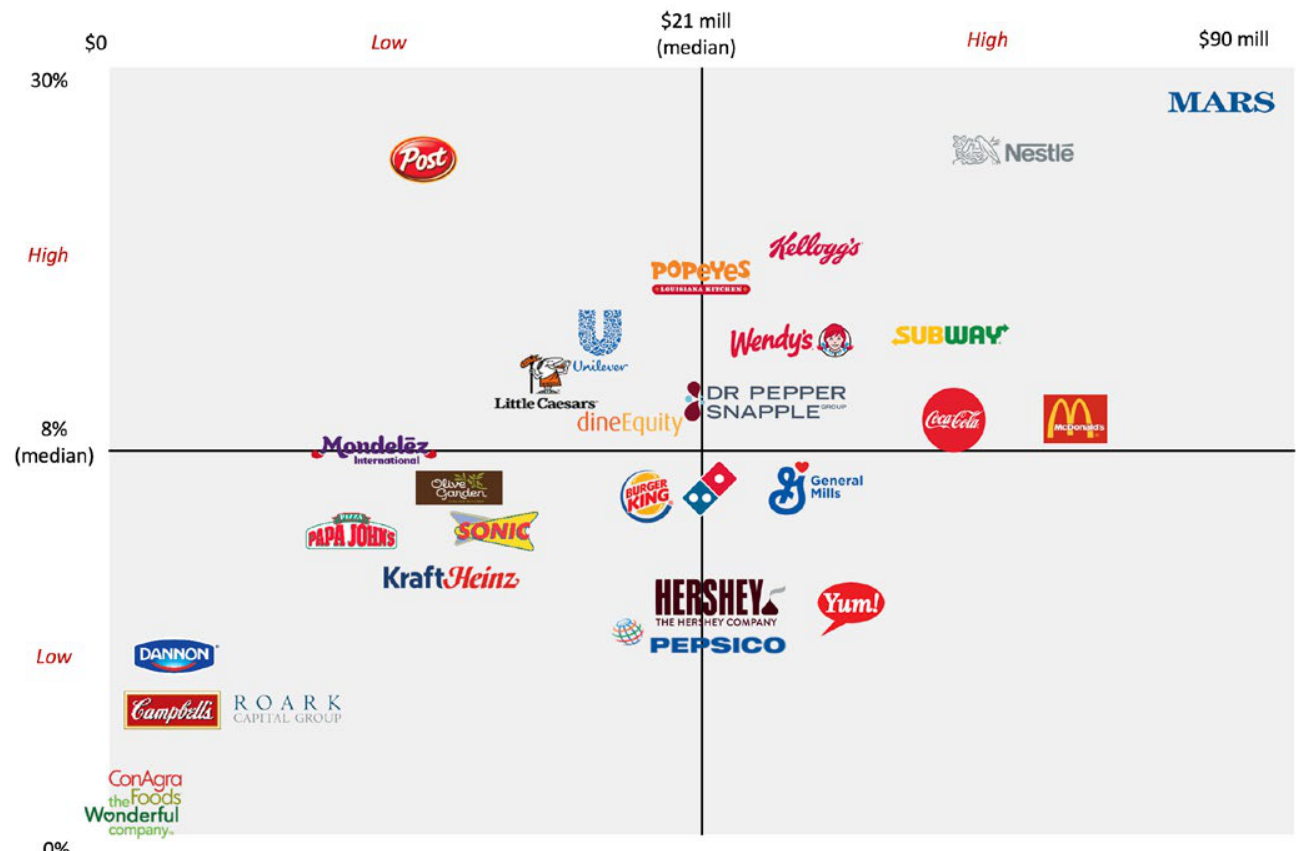
FIGURE 4. COMPANY INVESTMENTS IN SPANISH-LANGUAGE